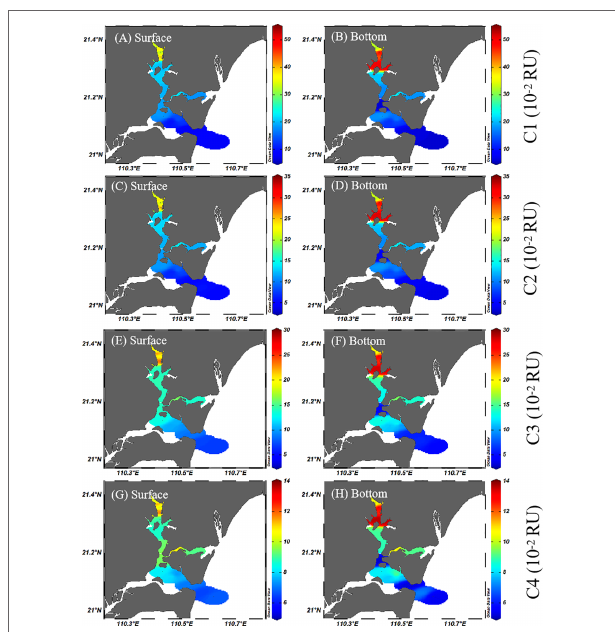
FIGURE 5 | Spatial distributions of fluorescence components C1 (A, B) , C2 (C, D) , C3 (E, F) and C4 (G, H) in the surface and bottom water of Zhanjiang Bay during the sampling